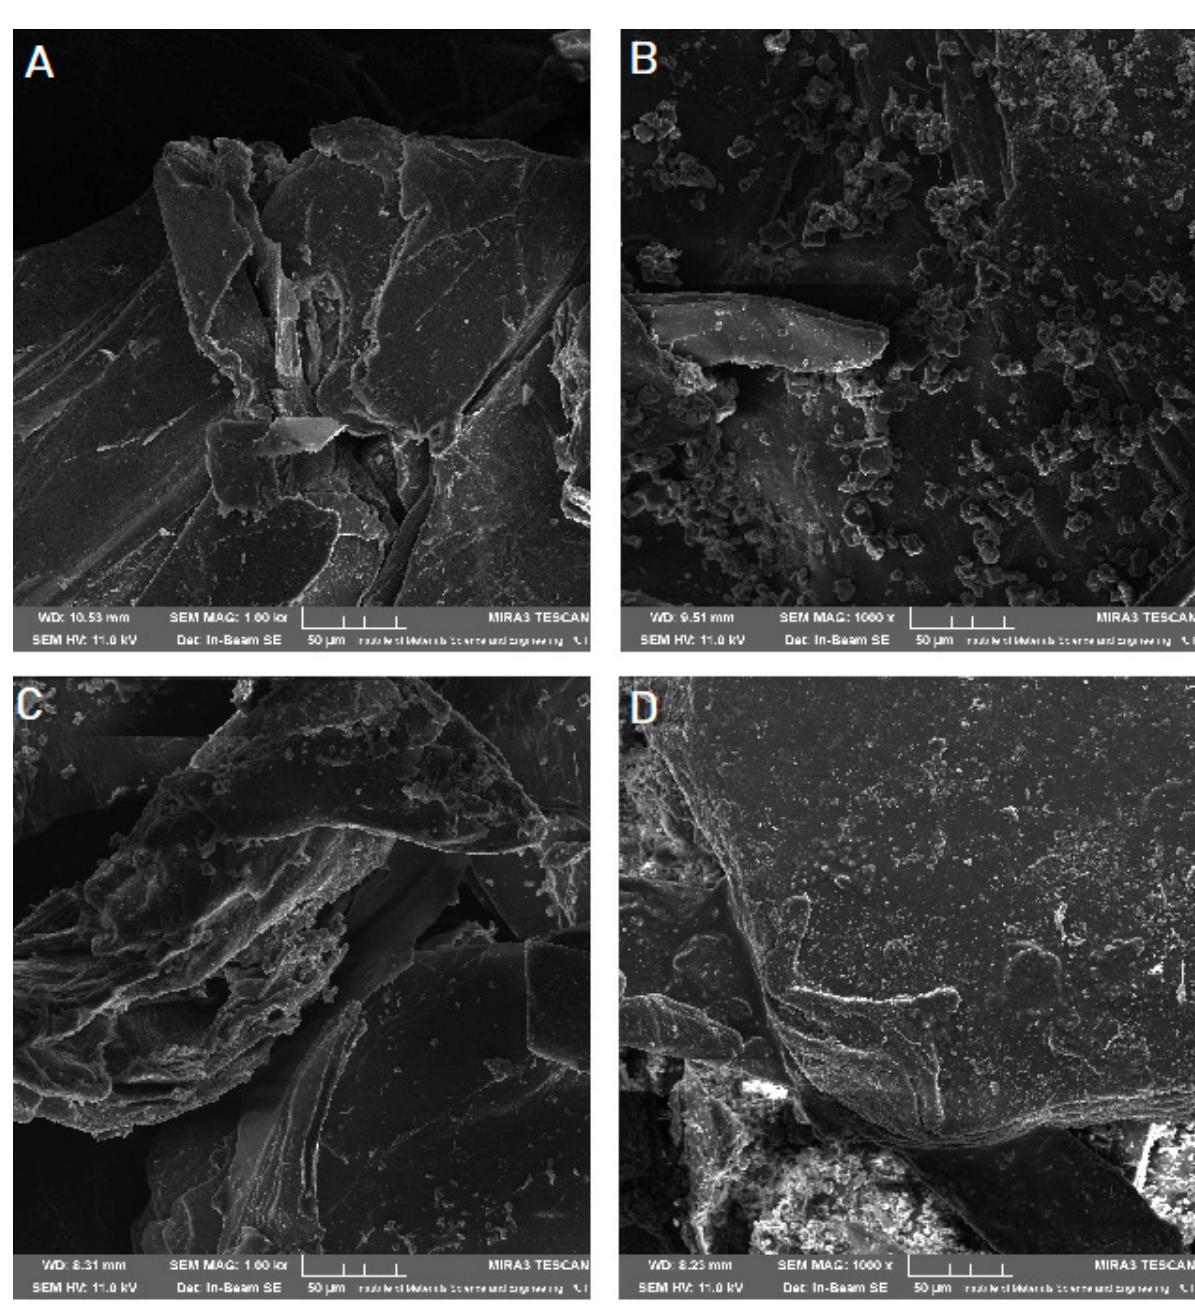
Figure 7. SEM images of chitosan 80/1000 ( A ) and its system with CVD in a weight ratio: 1:1 ( B ), 1:5 ( C ), 1:10 ( D ) at 1000 × magnification.